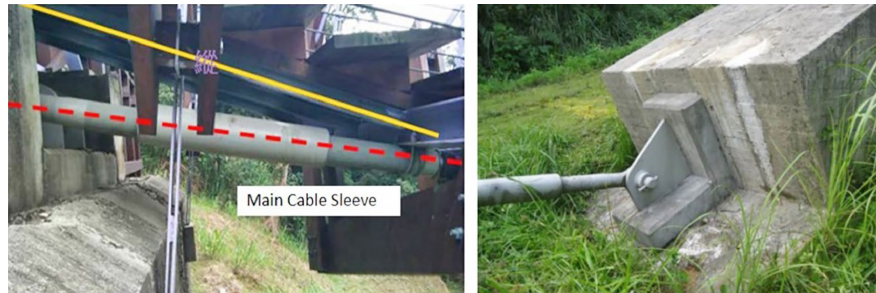
Figure 3. Pictures taken at anchorage of main cable (left) and stabilizing cable